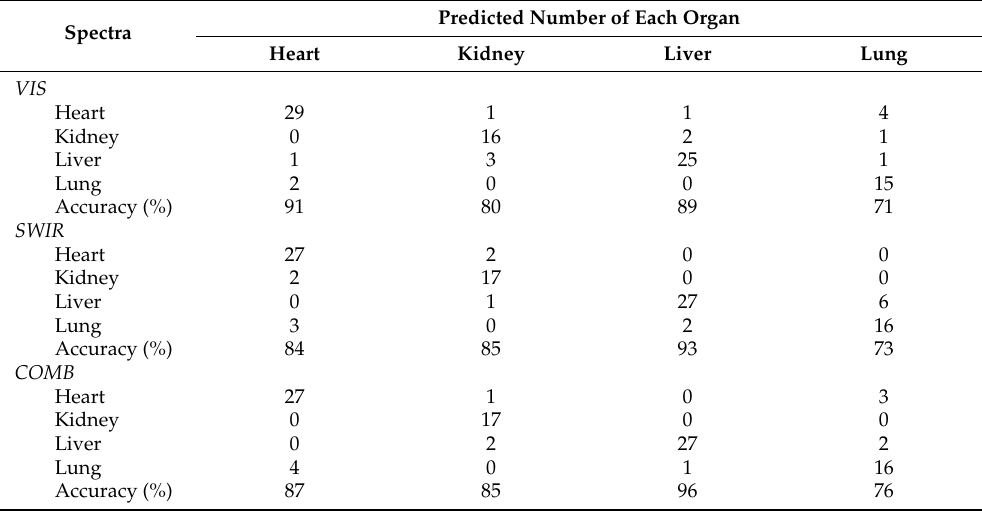
Table 6. Livestock organ classification from hyperspectral sensors using random forest (RF) clas- sification for visible (VIS), short-wave infrared (SWIR) and combination VIS and SWIR (COMB) hyperspectral sensors on the in-sample